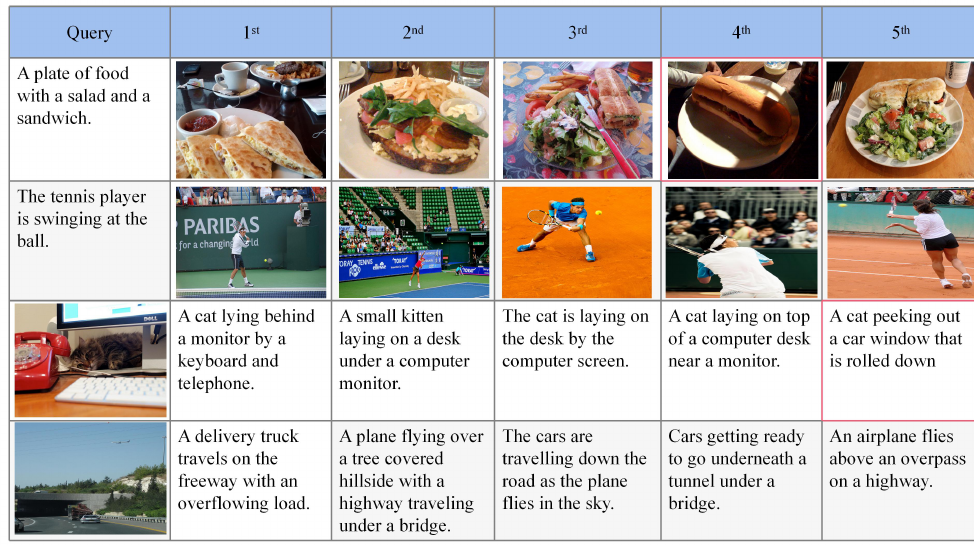
Figure 7. The visualization of cross-modal hash retrieval results. The first column is query data and the rest of the columns are the top five retrieved results. The data in the red box indicate that semantically incompatible data were